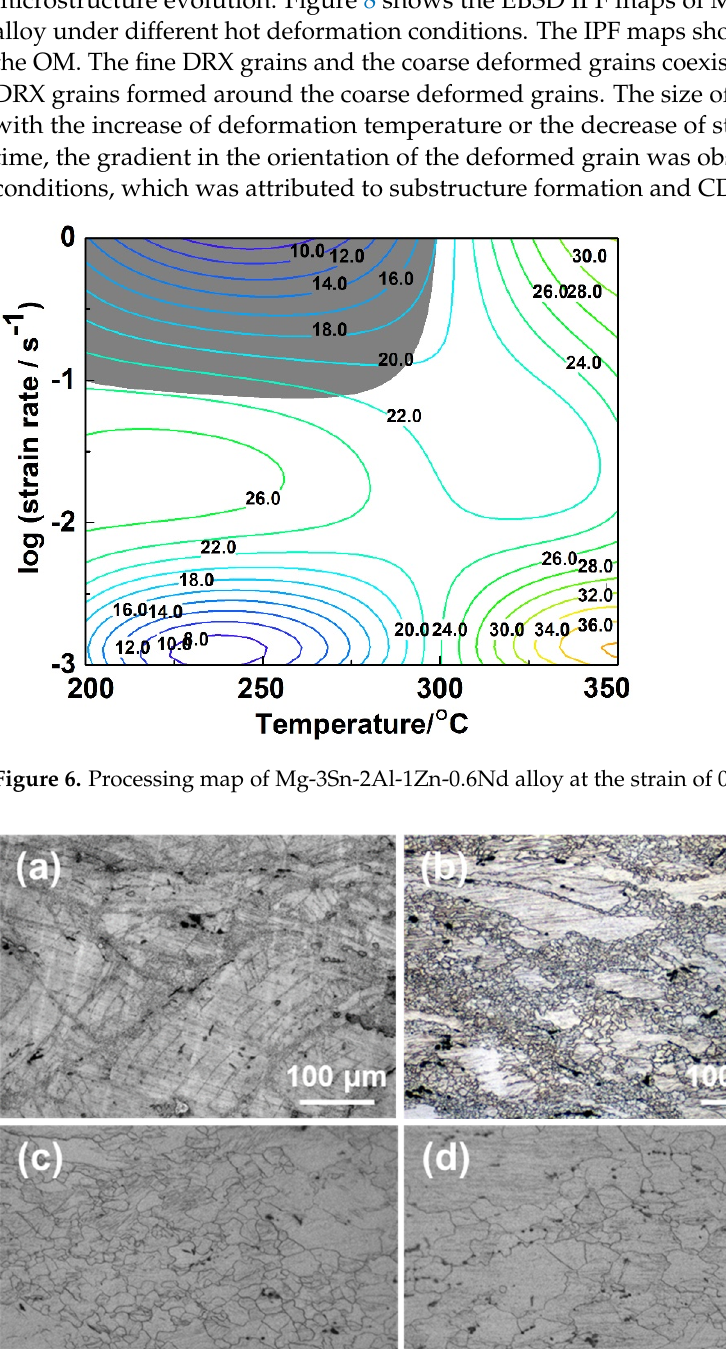
Figure 8. EBSD IPF maps of Mg-3Sn-2Al-1Zn-0.6Nd alloy under different hot deformation condi- tions: ( a ) 250 °C/0.01 s − 1 , ( b ) 300 °C/0.01 s − 1 , ( c ) 350 °C/0.01 s − 1 , and ( d ) 350 °C/0.001 s − 1 . To investigate texture evolution under the different deformation conditions, the pole figures by EBSD of the Mg-3Sn-2Al-1Zn-0.6Nd alloys and macro texture by XRD under different hot deformation conditions are shown in Figures 9 and 10. As can be seen from Figure 9, similar textures were obtained in the Mg-3Sn-2Al-1Zn-0.6Nd alloy under dif- ferent hot deformation conditions. The pole density points were distributed at both ends of the CD on {0001} pole figure, and the pole density points were distributed along with the TD on {11 2 (cid:3364) 0} pole figure and {10 1 (cid:3364) 0} pole figure. It suggests that <0001>//CD texture is the dominant texture for the Mg-3Sn-2Al-1Zn-0.6Nd alloy after hot deformation. In contrast to Figure 9 and Figure 10, this trend remains largely consistent with the macro texture.